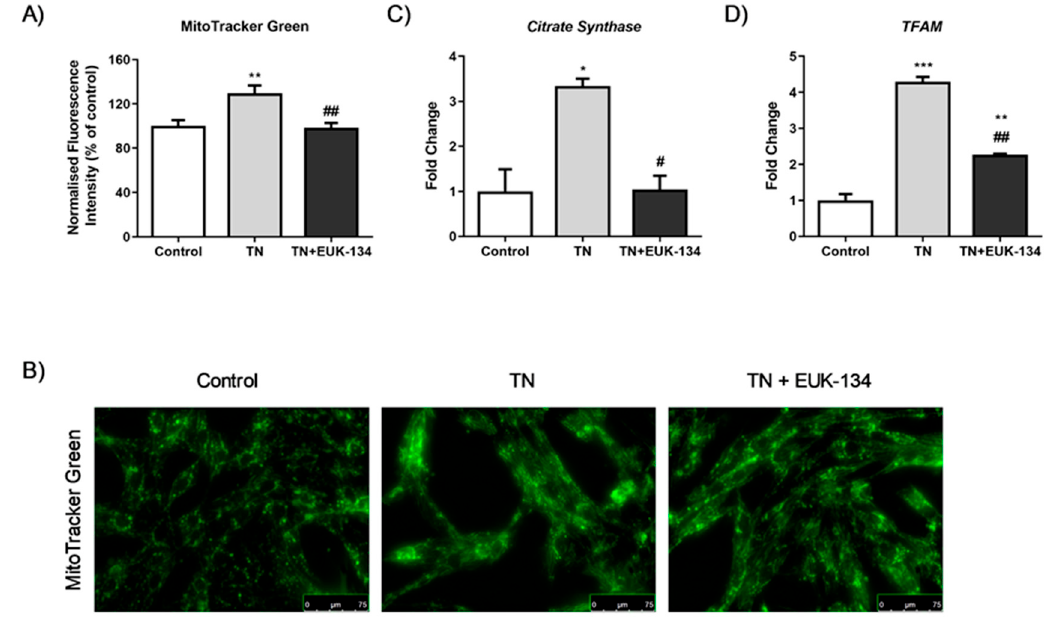
Figure 4. Mitochondrial biogenesis of tunicamycin-treated cells with or without EUK-134. ( A ) Representative graph of mitochondrial mass / volume showing the relative change (%) in MitoTracker Green fluorescence intensity, normalised to protein content. Data represent the mean ± SEM ( n = 12). * p ≤ 0.033, ** p < 0.002, against vehicle control or tunicamycin alone (#). ( B ) Representative images of mitochondrial staining in human skeletal muscle myoblast using MitoTracker Green acquired under cell culture conditions. Images captured at 40 × magnification. Scale bar = 75 µ m. Brightness was adjusted equally in each image to enhance visualisation. ( C , D ) Relative fold changes in mRNA expression of Citrate Synthase and TFAM . Data represent the mean fold change normalised to 18S housekeeper gene ± SEM of ∆ Ct values, ( n = 3). * p ≤ 0.033, ** p < 0.002, and *** p < 0.001 against vehicle control or tunicamycin alone (#).